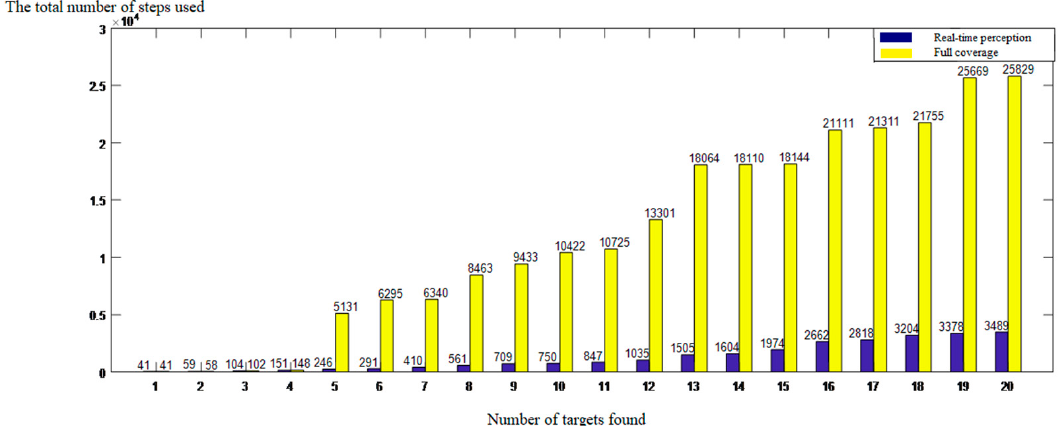
Figure 15. Comparison chart of the number of steps used when searching for a target.